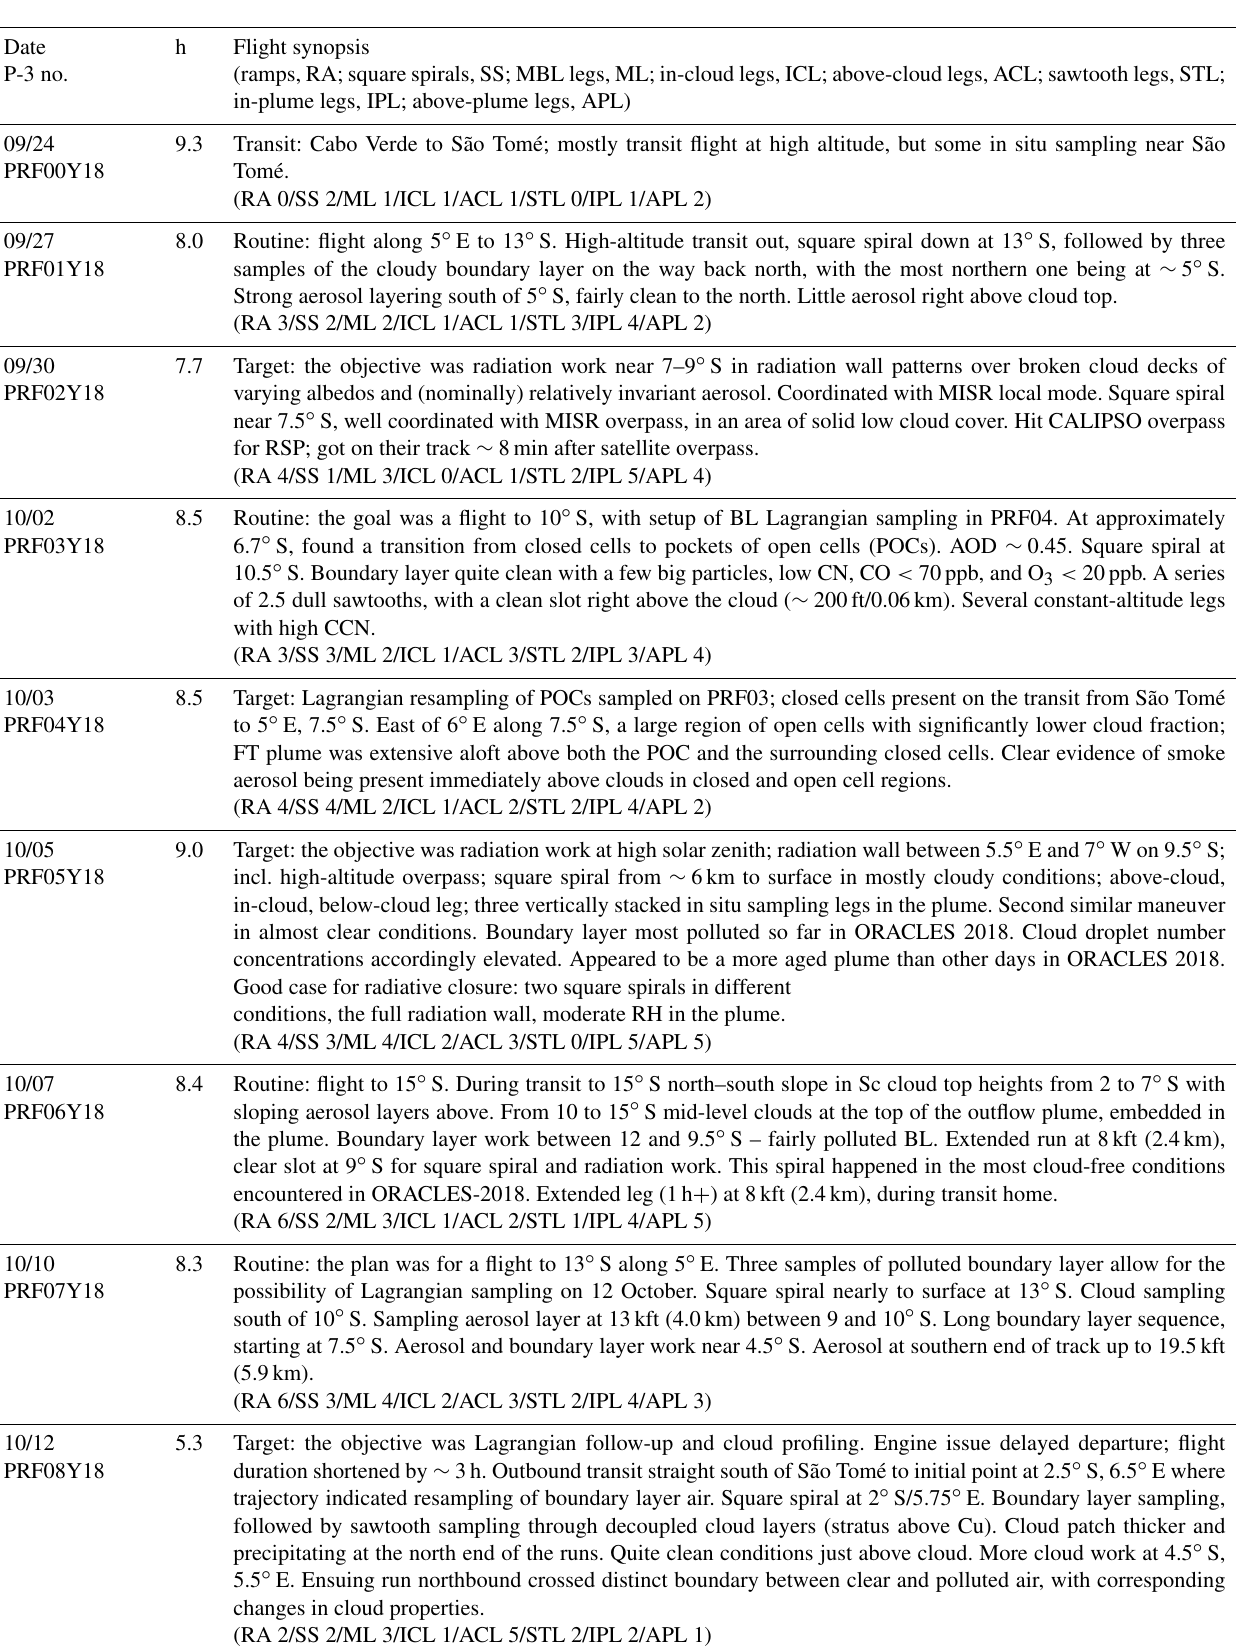
Table A3. The 2018 flight summary for the P-3 aircraft. Date h Flight synopsis P-3 no. (ramps, RA; square spirals, SS; MBL legs, ML; in-cloud legs, ICL; above-cloud legs, ACL; sawtooth legs, STL; in-plume legs, IPL; above-plume legs, APL)